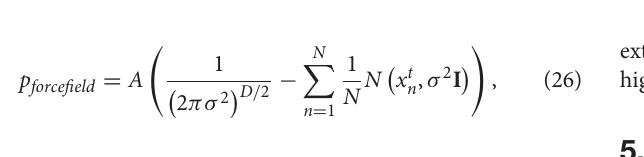
FIGURE 7 | The results of rotating the iron wire by 45 degrees with the bottom part covered. Compared with CPD+Physics and CDCPD2, our algorithm can provide better estimation results. (A) No cover, (B) CPD, (C) CPD+LLE, and (D) Ours.